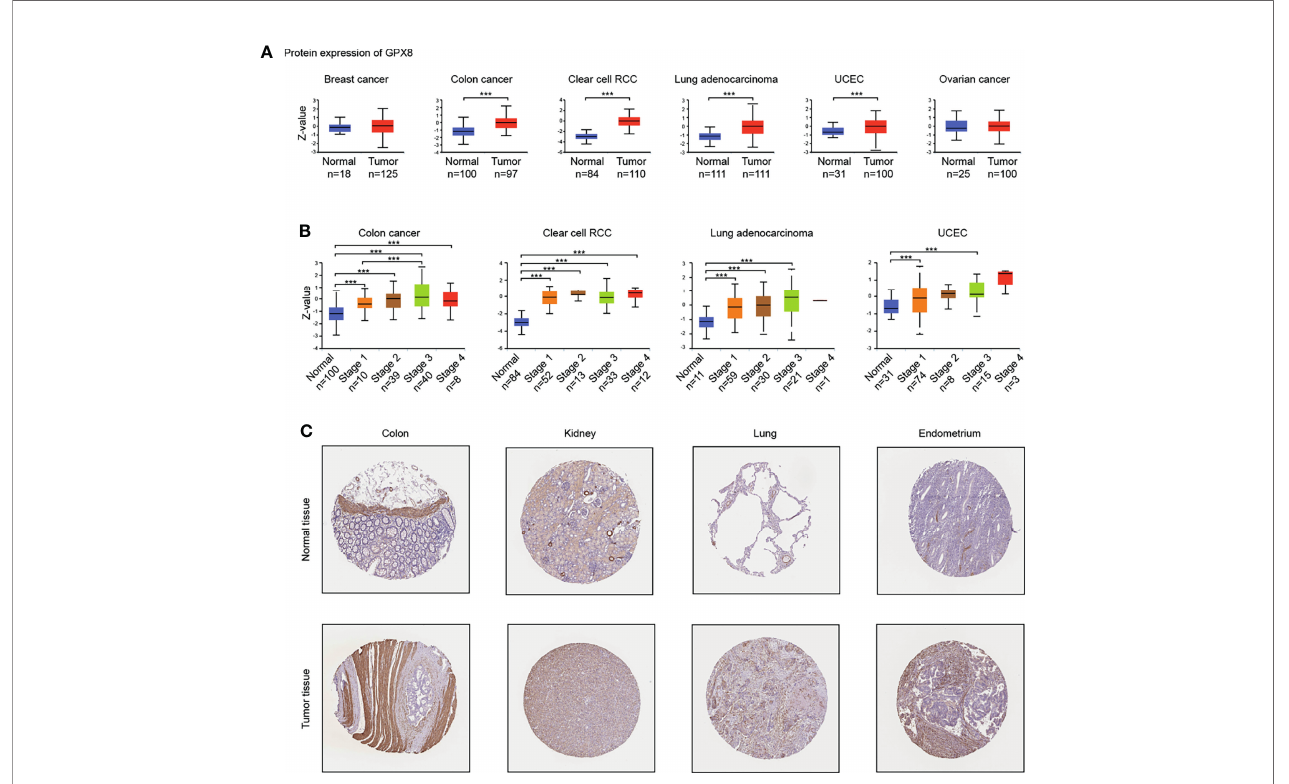
FIGURE 2 | The expression of GPX8 protein in different cancers. (A) Based on the CPTAC analysis (http://ualcan.path.uab.edu/analysis-prot.html), the expression of GPX8 protein was analyzed in Breast cancer, colon cancer, clear cell RCC, Lung adenocarcinoma, UCEC, Ovarian cancer. (B) The expression of GPX8 protein was analyzed by the main pathological stages of colon cancer, clear cell RCC, Lung adenocarcinoma, UCEC. (C) Based on the HPA database (http://www.proteinatlas. org/), the expression of GPX8 protein in normal or tumor tissue of colon, kidney, lung, the endometrium was displayed. ***P <